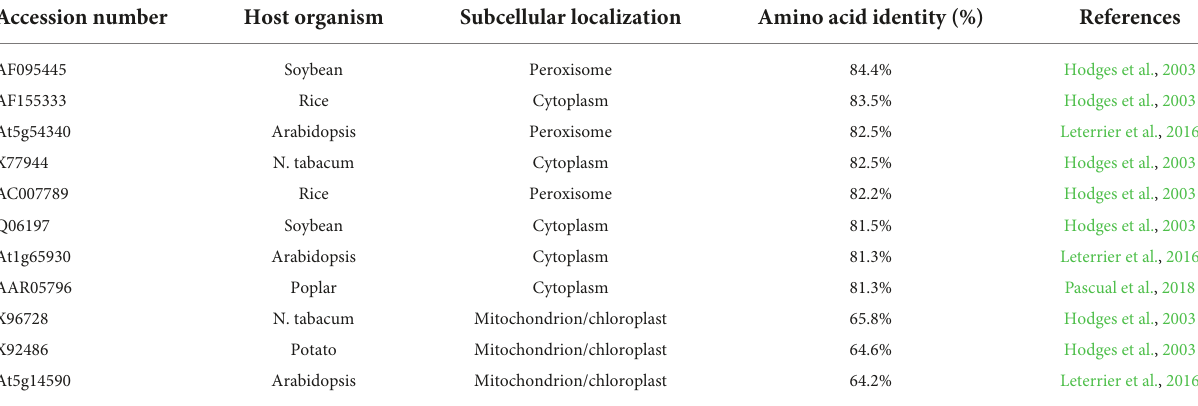
TABLE 1 The similarity of amino acid sequences of GH_D13G1452 to other plants’